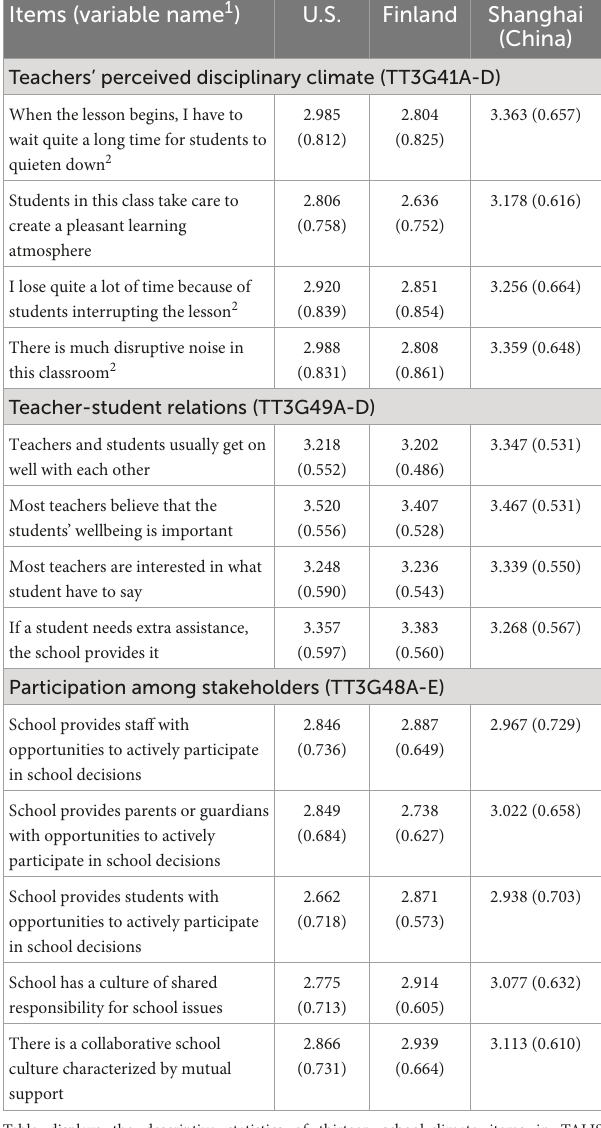
Table displays the descriptive statistics of thirteen school-climate items in TALIS 2018 questionnaire. Item responses were rated on a four-point Likert scale (1 =